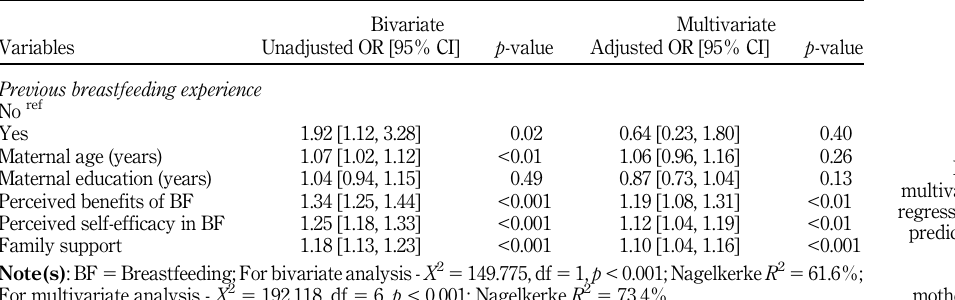
Table 5. Bivariate